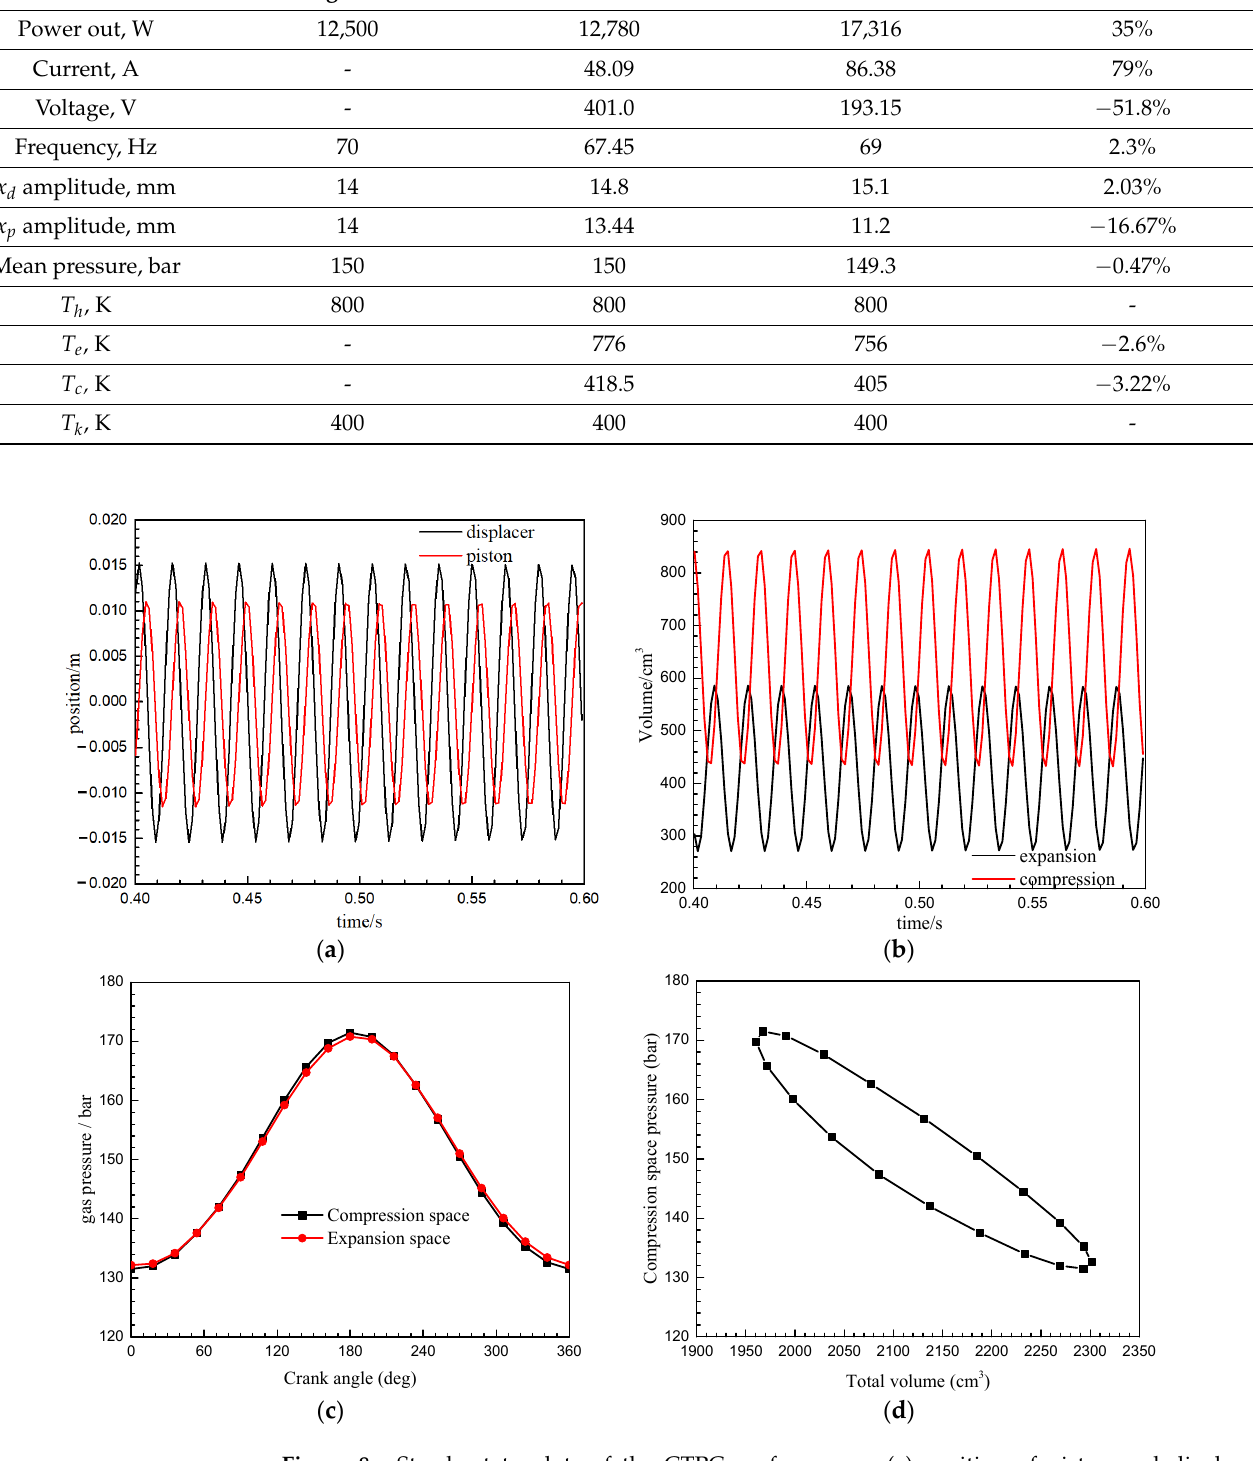
Figure 8. Steady-state plots of the CTPC performance: ( a ) position of piston and displacer, ( b ) expansion and compression volume, ( c ) gas pressure, ( d ) PV Cycle diagram under